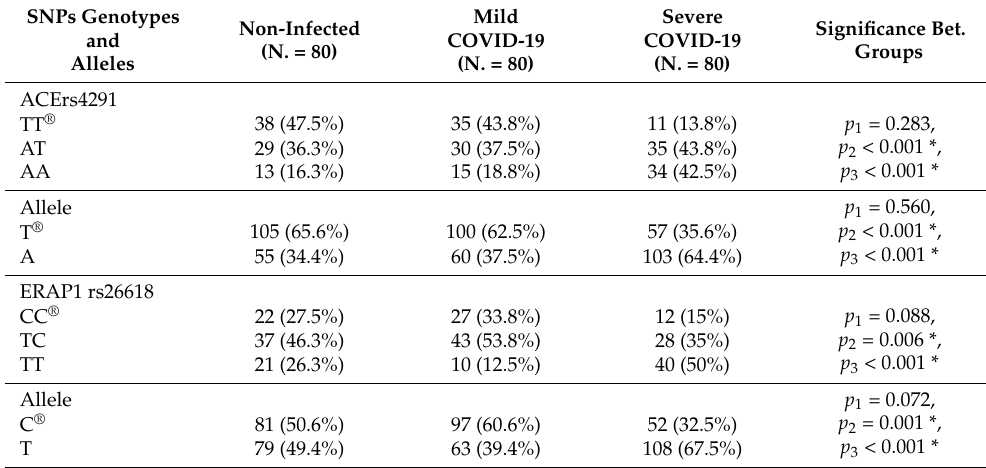
Table 3. Comparison between the three studied groups according to different SNPs. SNPs Genotypes and